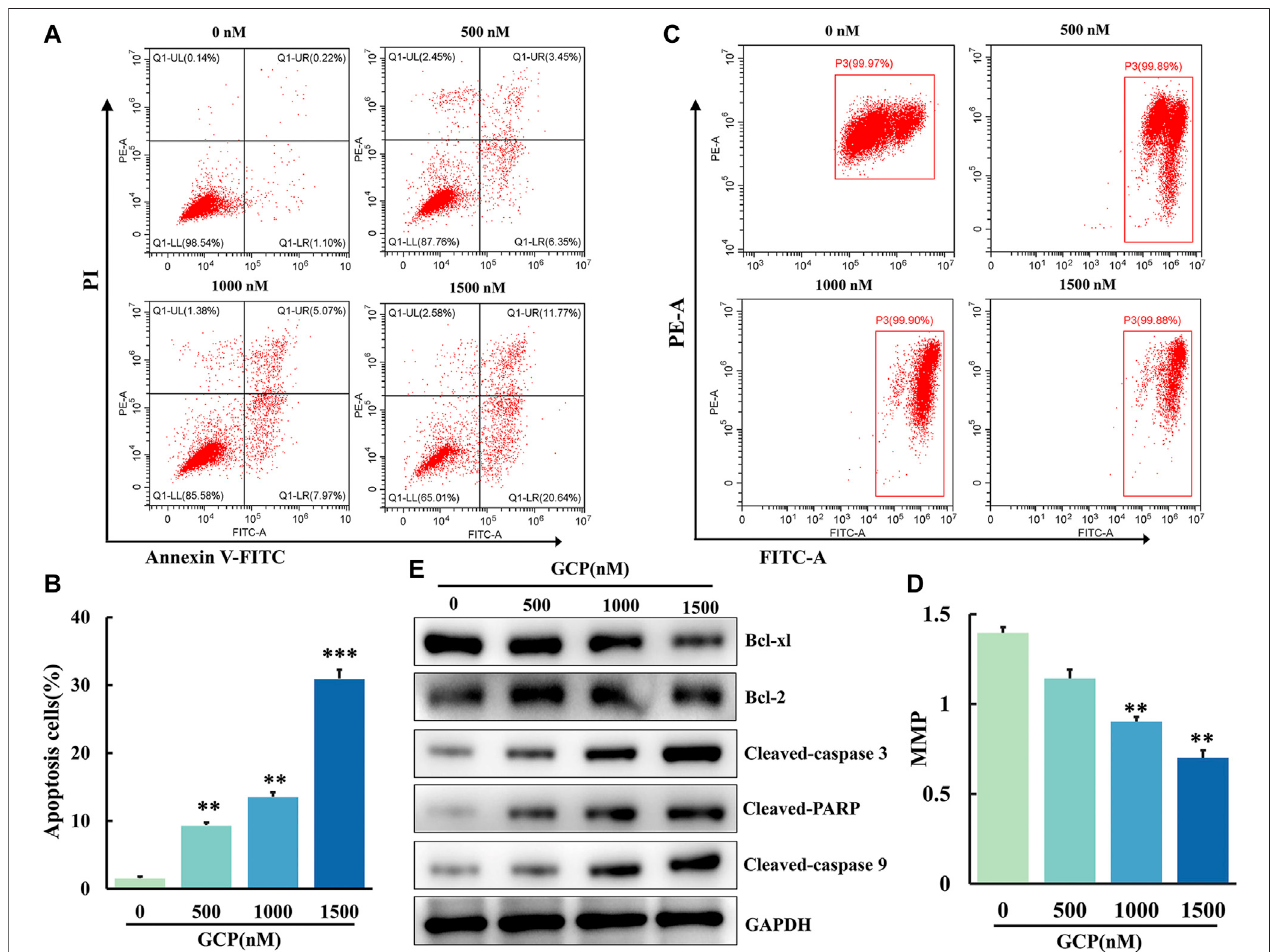
FIGURE 5 | GCP induces apoptosis by mitochondrial pathway in HeLa cells. (A, B) AV/PI fl ow cytometry was used to detect the effect of GCP on the apoptosis. Thepercentage ofapoptosiscellsisshownasmean ± SDfromthreeindependentexperiments. (C,D) Themitochondrialmembrane potentialafterGCPtreatment were measuredusingJC-1stainingby fl owcytometry.Eachbar representsasmean ± SDfromthree independent experiments. * p < 0.05,** p < 0.01,*** p < 0.001vscontrol. (E) Apoptosis-relatedproteinexpression(Bcl-xl,Bcl-2,Cleaved-caspase3,CleavedPARP,Cleaved-caspase9)inHeLacellsafterGCPtreatmentat0,500,1,000, 1500 nM for 48 h was analyzed by western